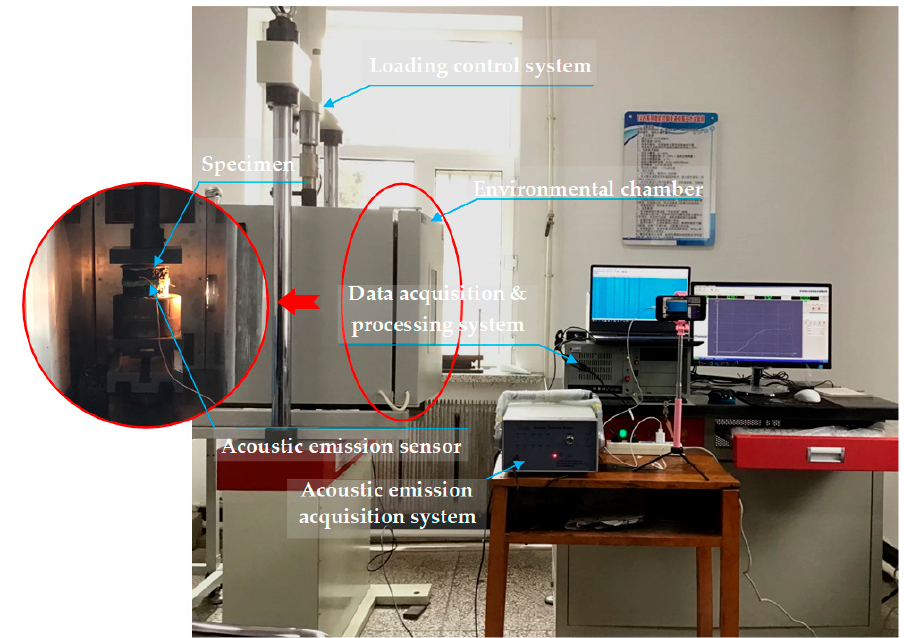
Figure 3. High-temperature uniaxial compression test used in this study.